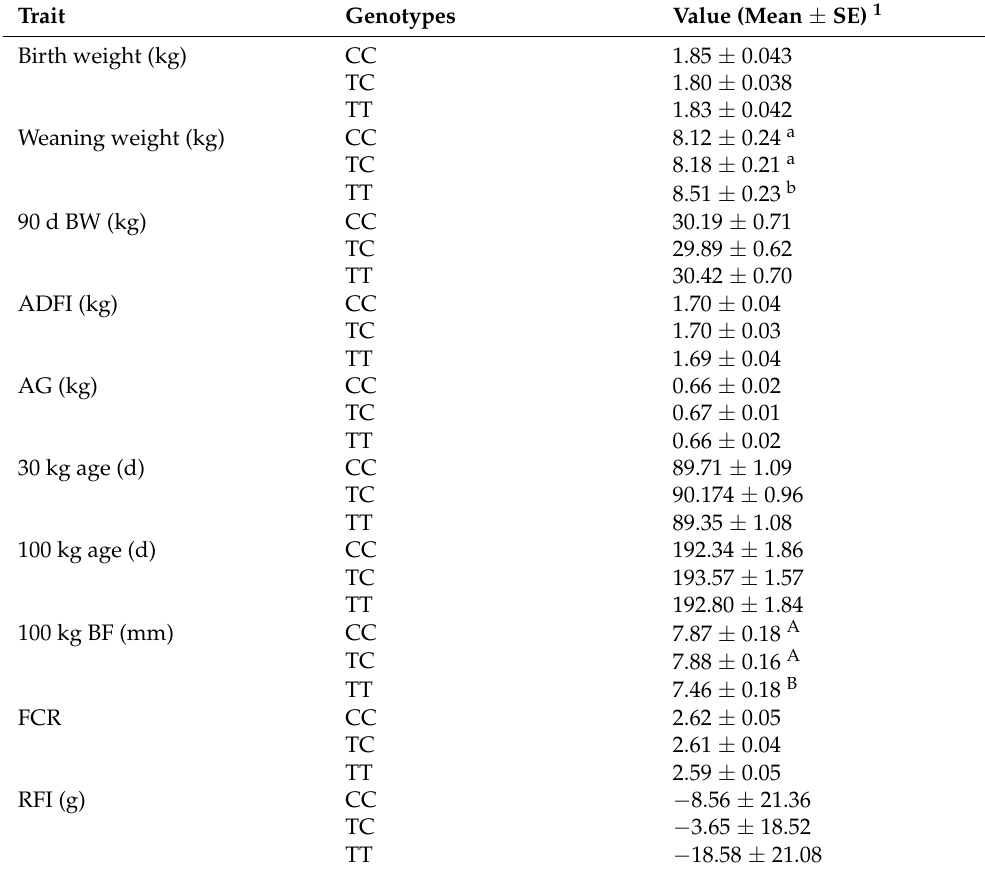
Table 5. Association of ALGA0043483 of GPX2 with different feed efficiency traits in 600 Duroc pigs.